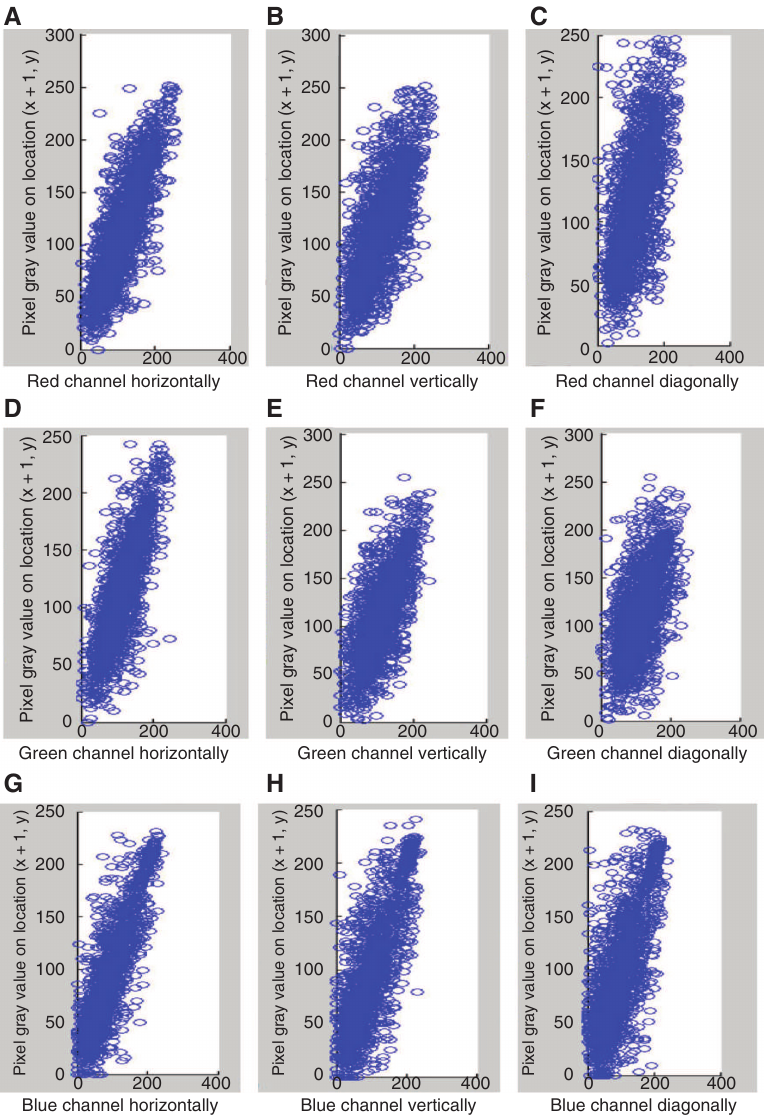
Figure 7: Correlation Distribution of Red, Green, and Blue Channels of the Original Color Image.